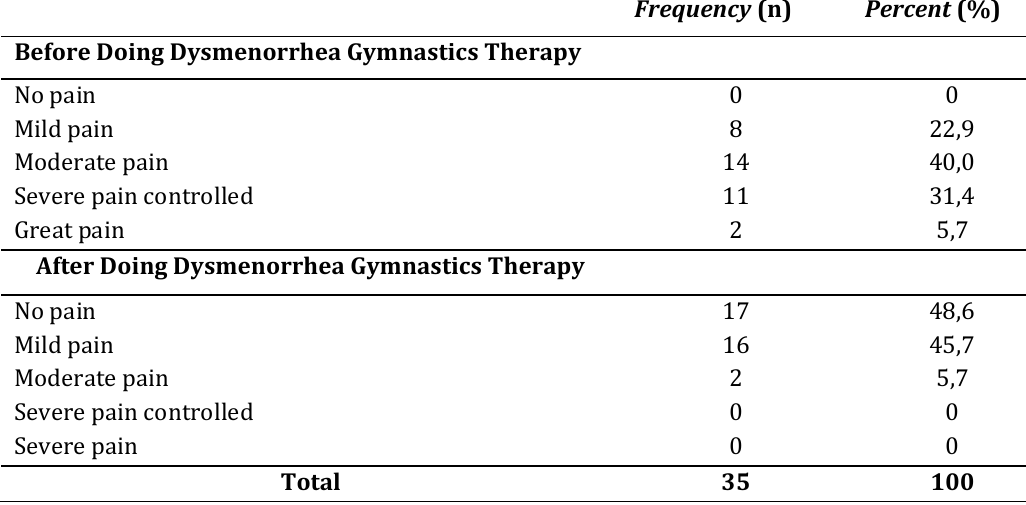
The Decreased Rate of Menstrual Pain in Young Women Before and After Performing Dysmenorrhea Gymnastics